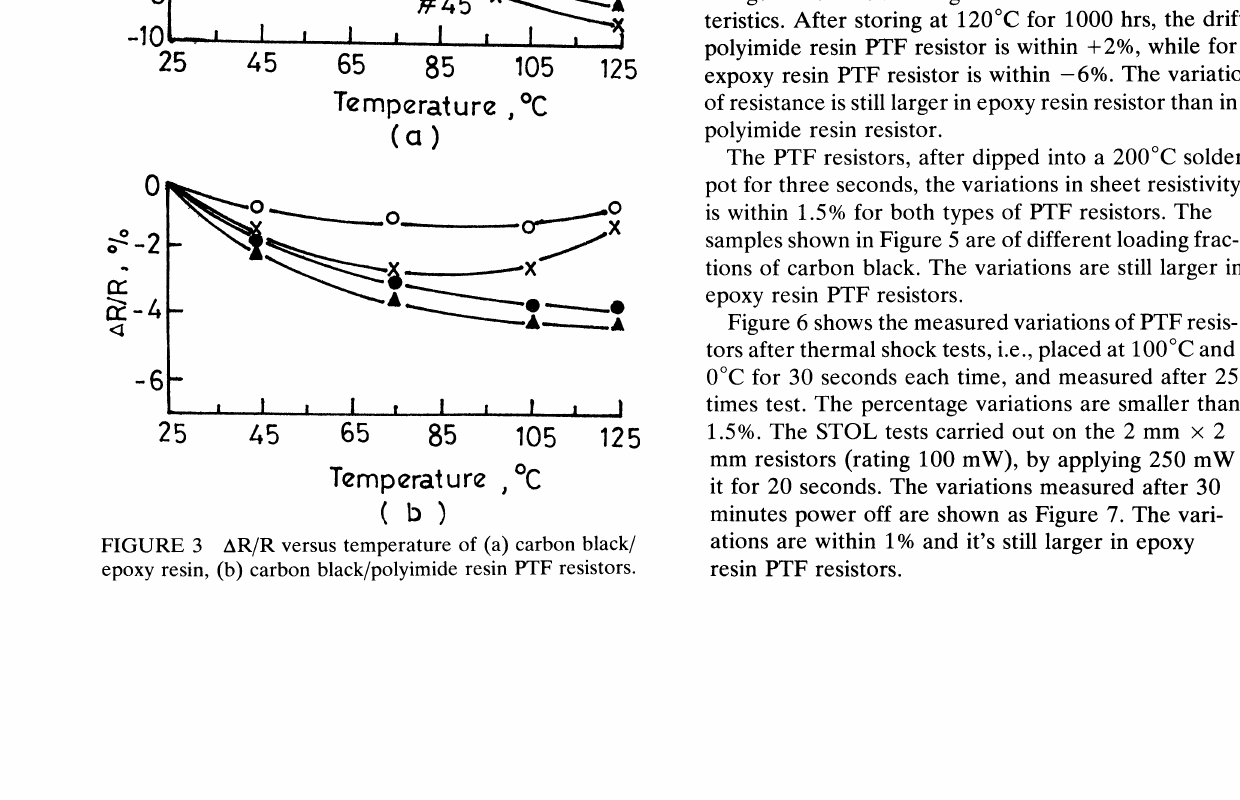
FIGURE 2 AR/R versus temperature of carbon black/polyimide resin resistors (ID.